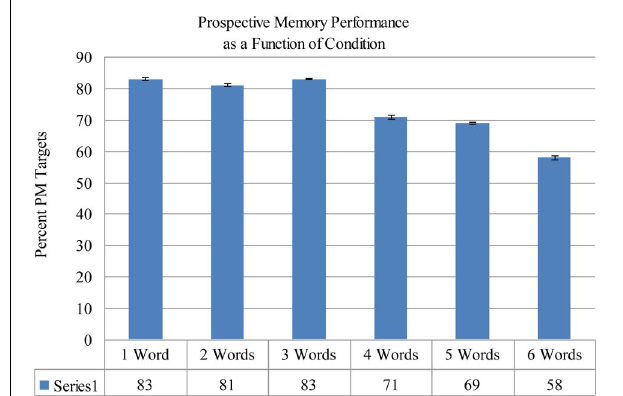
FIGURE 1 | Percent of prospective memory targets detected as a function of condition. Bars represent standard error.